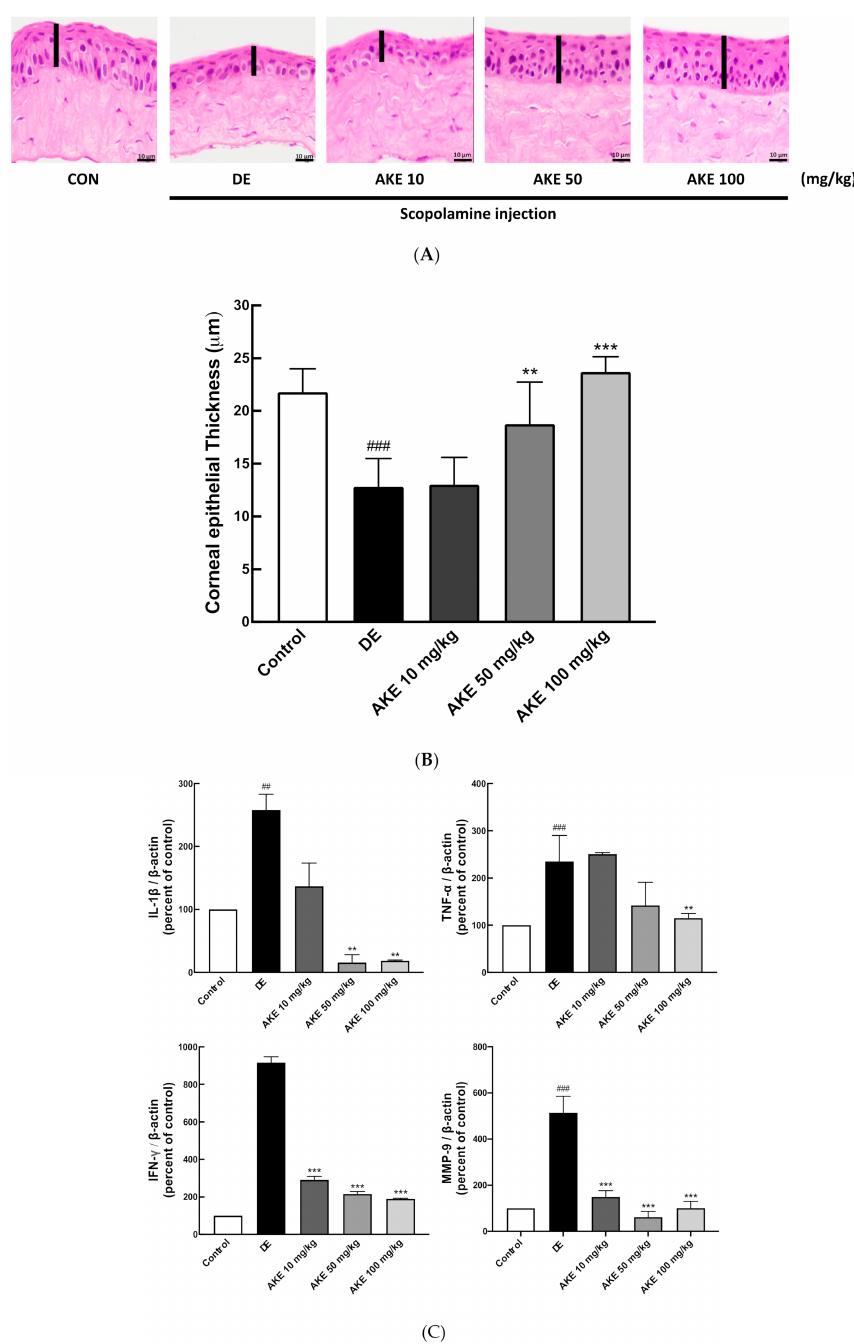
Figure 2. E ff ects of A. koraiensis ethanol extracts (AKE) on the corneal epithelial thickness and inflammatory cytokine expression. Dry eye (DE) was reportedly induced by scopolamine injection, and AKE was administered at 0 (control; CON which was not induced by scopolamine injection, DE), 10 (AKE 10), 50 (AKE 50), or 100 mg / kg (AKE 100). ( A ) Representative H and E staining images of histological sections of corneas. ( B ) Quantitative analysis of A. ( C ) Expression of inflammatory cytokines was accessed by real-time PCR (RT-qPCR) for each target gene (IL-1 β , TNF- α , IFN- γ , and MMP-9). β -actin was used as an internal control. Each bar represents the mean ± SD of n = 7 mice per group. ## p < 0.01, ### p < 0.001 versus CON; ** p < 0.01, *** p < 0.001 versus DE. Data were analyzed statistically using one-way ANOVA followed by Tukey’s post hoc test. IL-1 β , interleukin 1 beta; TNF- α , Tumor necrosis factor alpha; IFN- γ , Interferon gamma; MMP-9, Matrix metallopeptidase